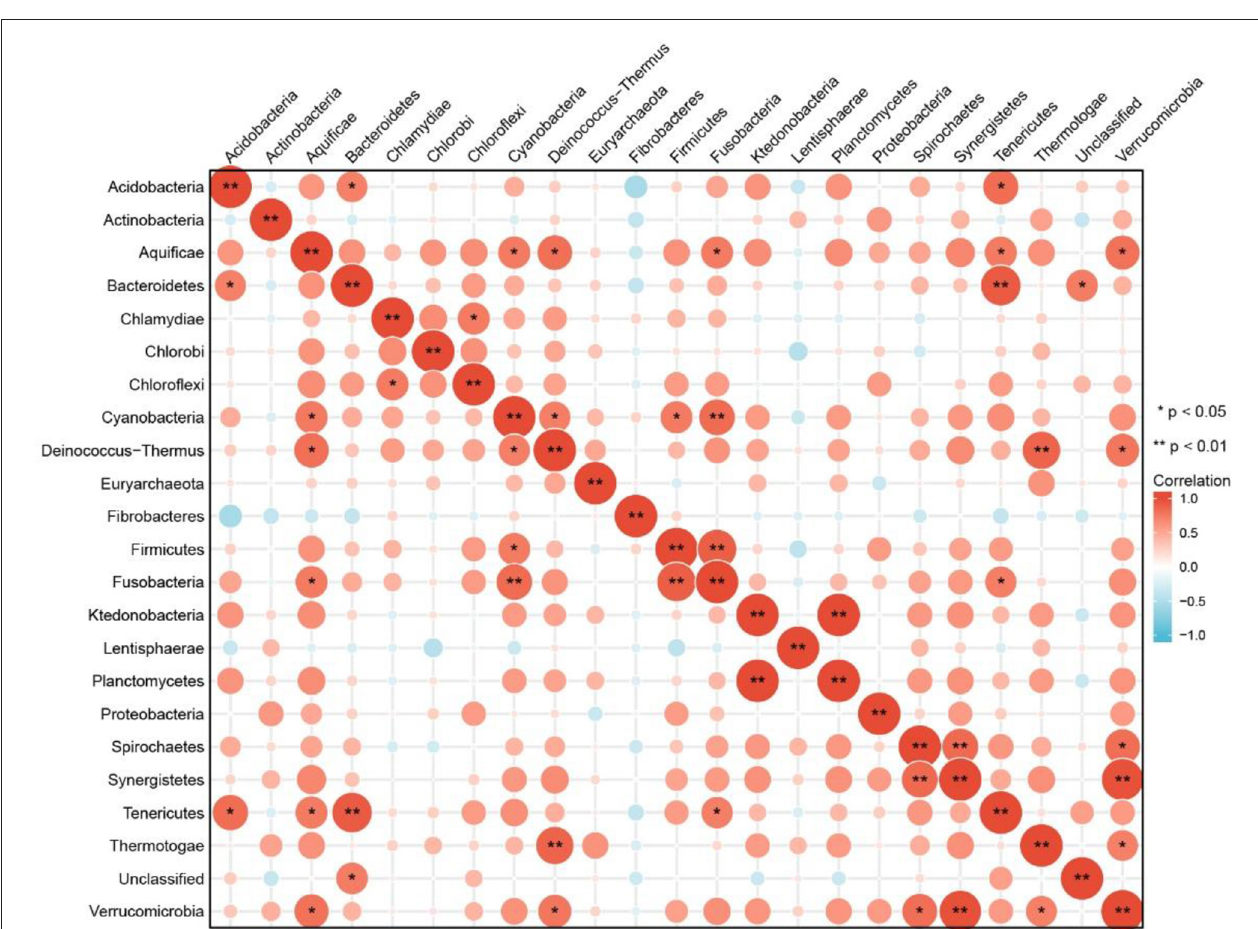
FIGURE 1 | Relativity analysis of intestinal microbiota in T1D based on multi-samples.